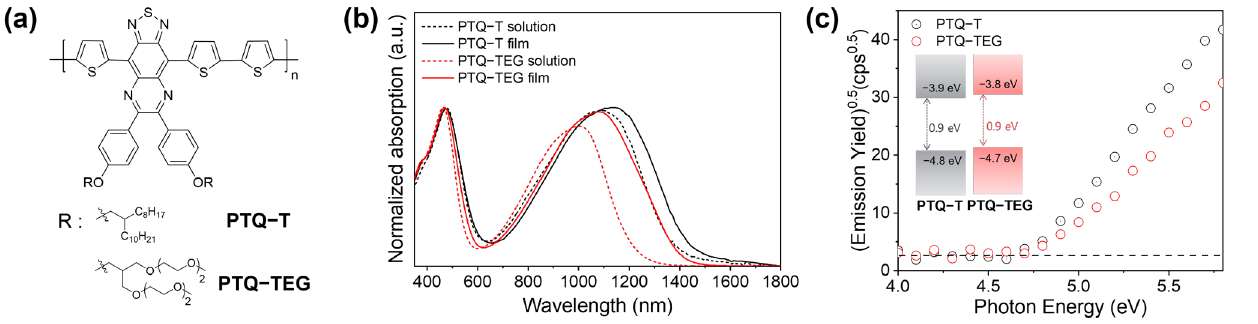
Figure 1. ( a ) Chemical structures; ( b ) absorption tendencies, and ( c ) electronic energy levels of the obtained